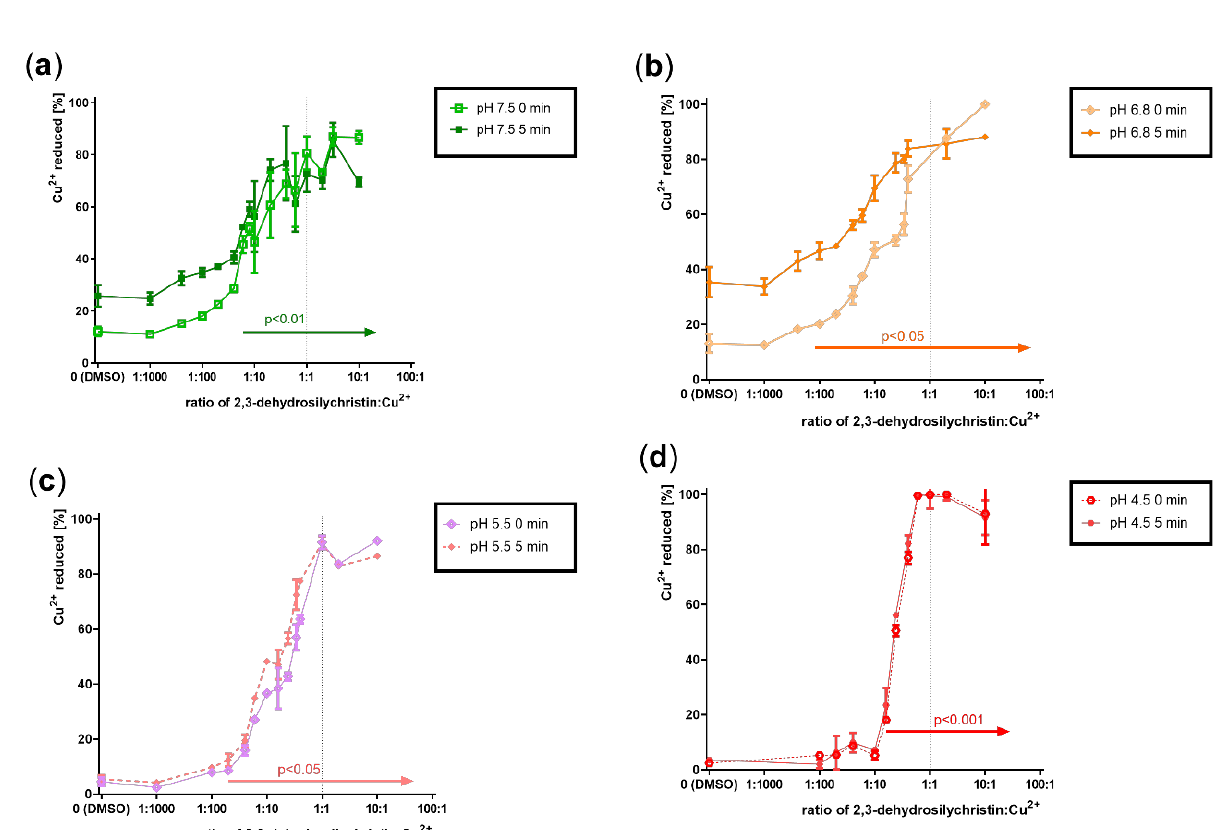
Figure 5. Cupric ion reduction potential of 2,3-dehydrosilychristin: ( a ) 2,3-dehydrosilychristin + Cu 2+ at pH 7.5; ( b ) 2,3- dehydrosilychristin + Cu 2+ at pH 6.8; ( c ) 2,3-dehydrosilychristin + Cu 2+ at pH 5.5; ( d ) 2,3-dehydrosilychristin + Cu 2+ at pH 4.5. The statistical comparison vs. the solvent (DMSO) is only shown for measurements performed at 5 min for a better overview.